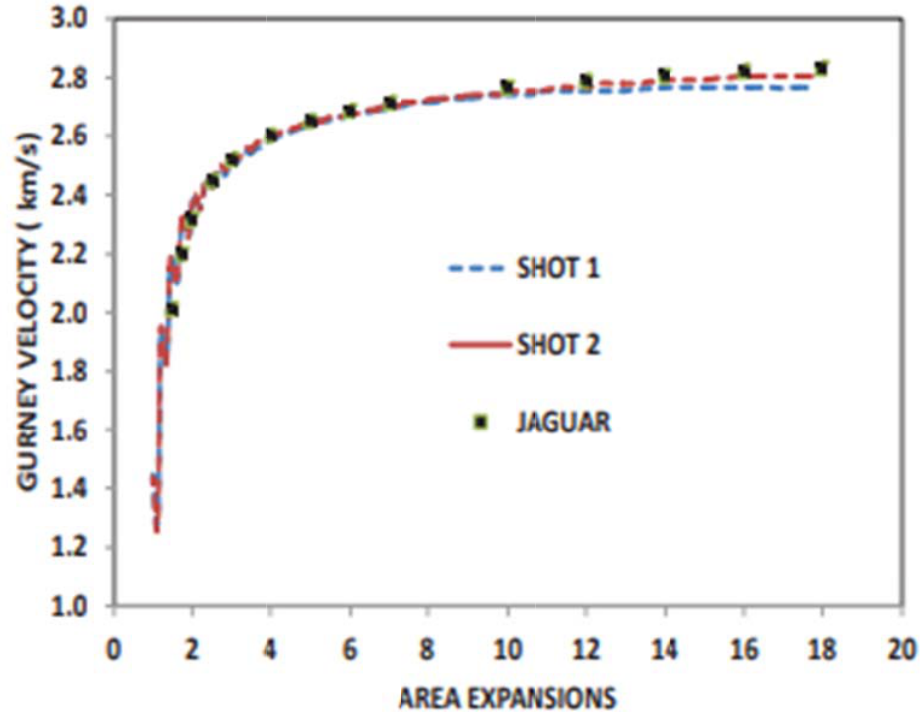
Figure 2 sho the cylinder density of 1. The analyse results for